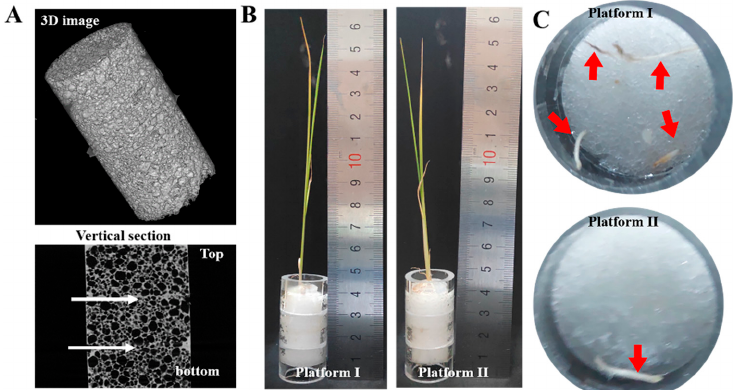
Figure 7. The multi-layer PDMS sponge lamination to mimic the heterogeneous soil. ( A ) micro-CT characterization of multi-layer PDMS sponge assembling, ( B ) growth of O. sativa seeds on multi-layer PDMS sponges, and ( C ) O. sativa roots development on multi-layer PDMS sponges. Platform I: the porosity from top to bottom is 40.89%, 46.56%, and 64.88%; platform II: the porosity from top to bottom is 64.88%, 46.56%, and 40.89%.